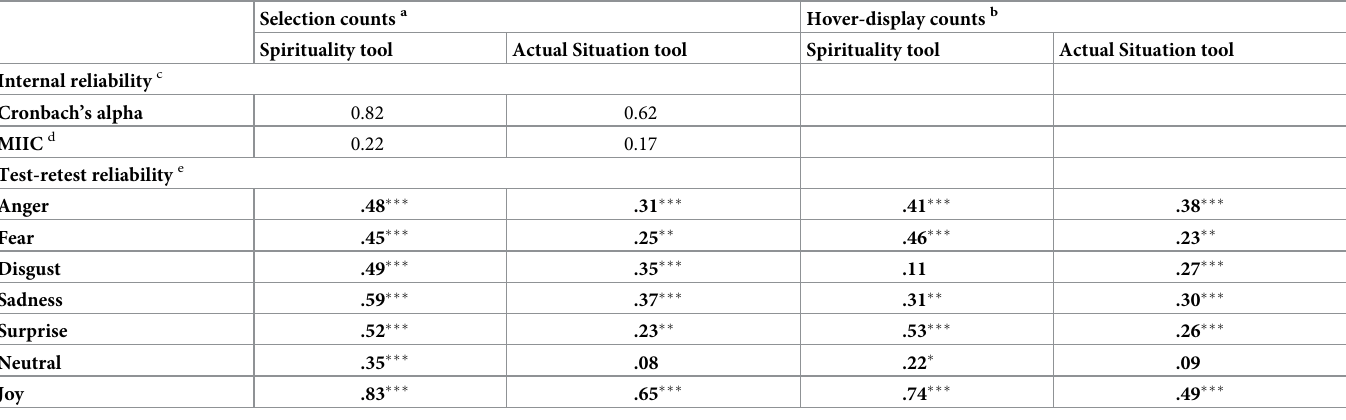
Table 6. Reliability of the Emotion Based Approach